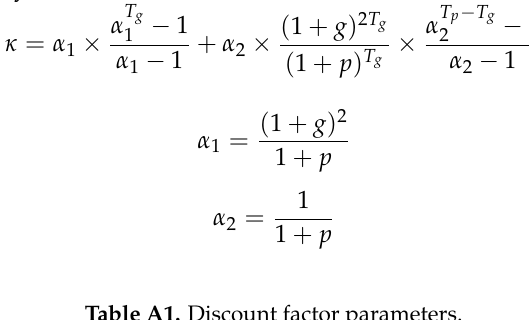
Table A1. Discount factor